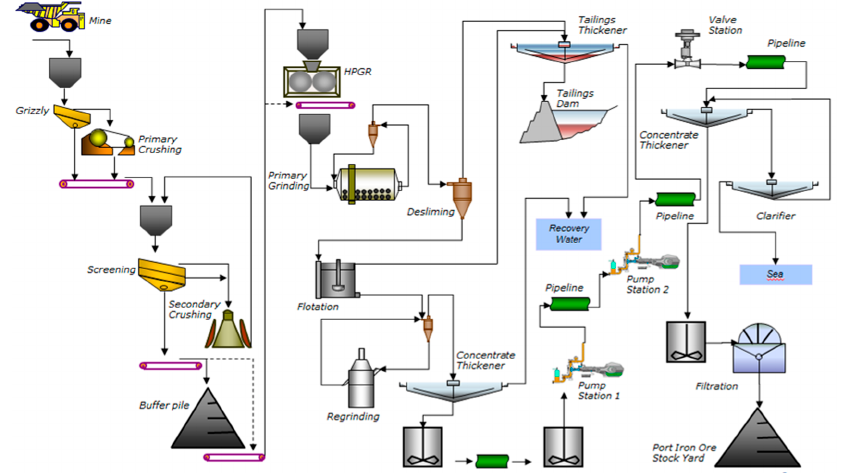
Figure 8. Minas-Rio process flowsheet [27].